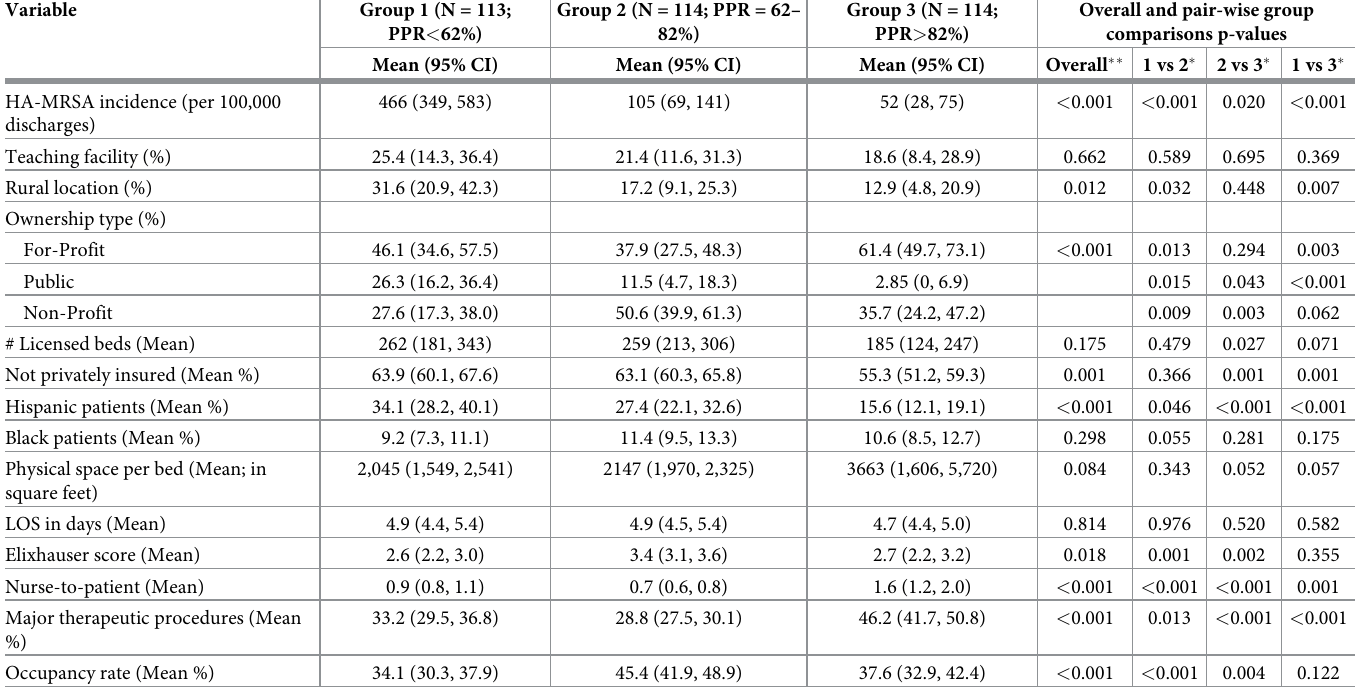
Table 3. Characteristics of 340 US hospitals grouped by the proportion of private patient rooms (PPRs), based on discharges between September 2015 and August